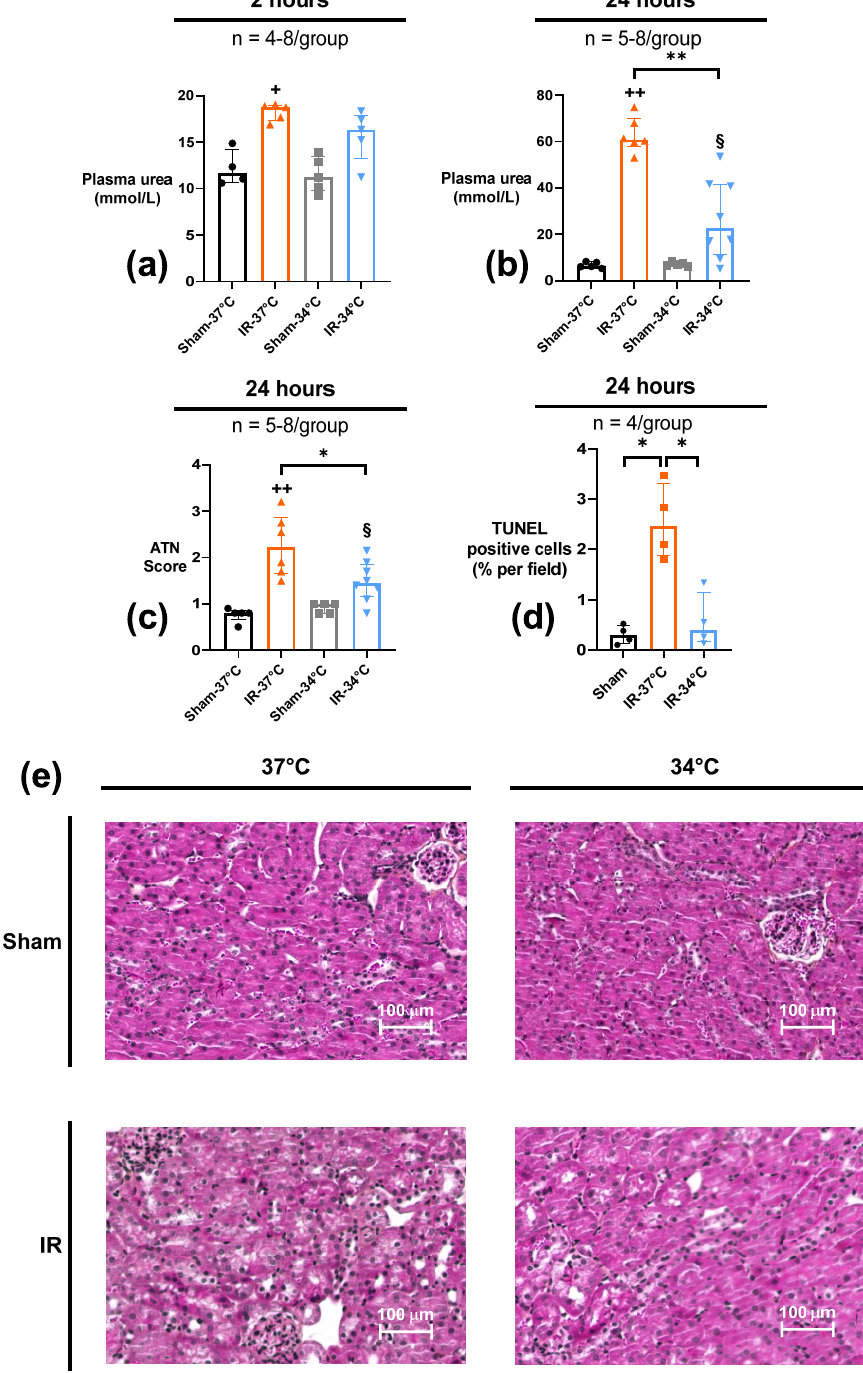
Figure 1. Renal functional parameters after 20 min of bilateral renal ischemia where the mice